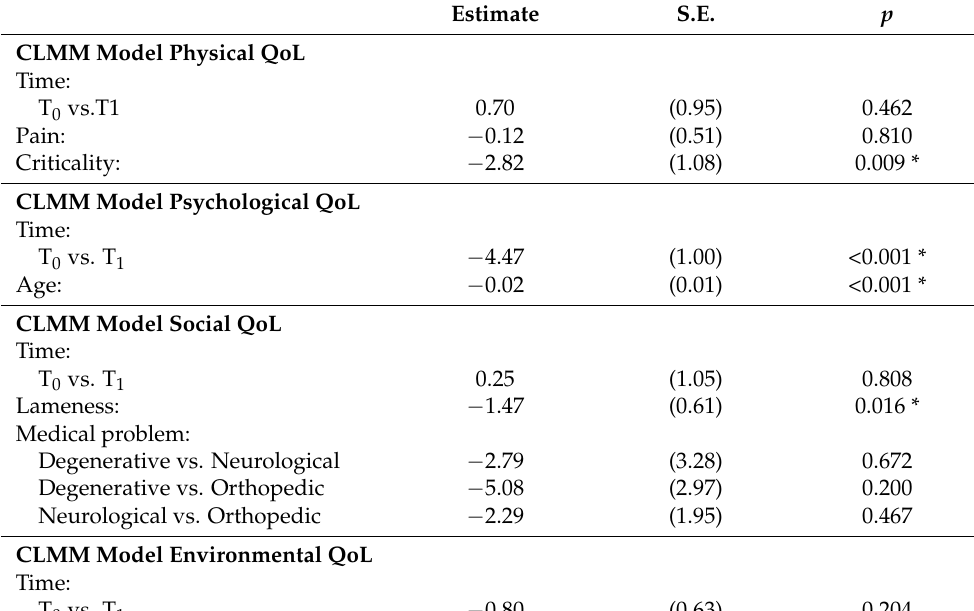
Table 1. Results of regression analyses on the MPQL. Note: * = p < 0.05. Estimate S.E.